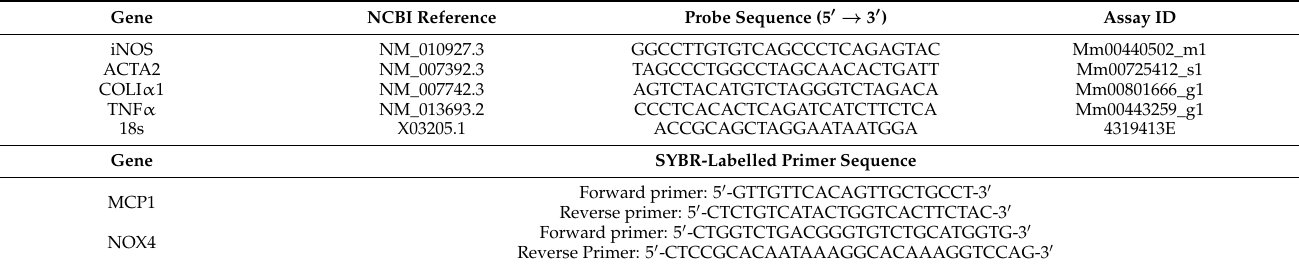
Table 1. Primer and Probe Sequences for